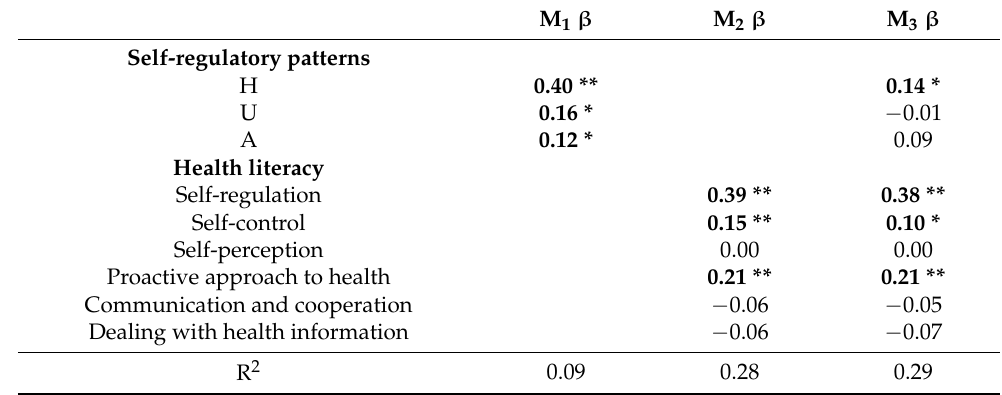
Table 5. Work-related and health-related personal resources and the association with general well- being: Results of the multiple